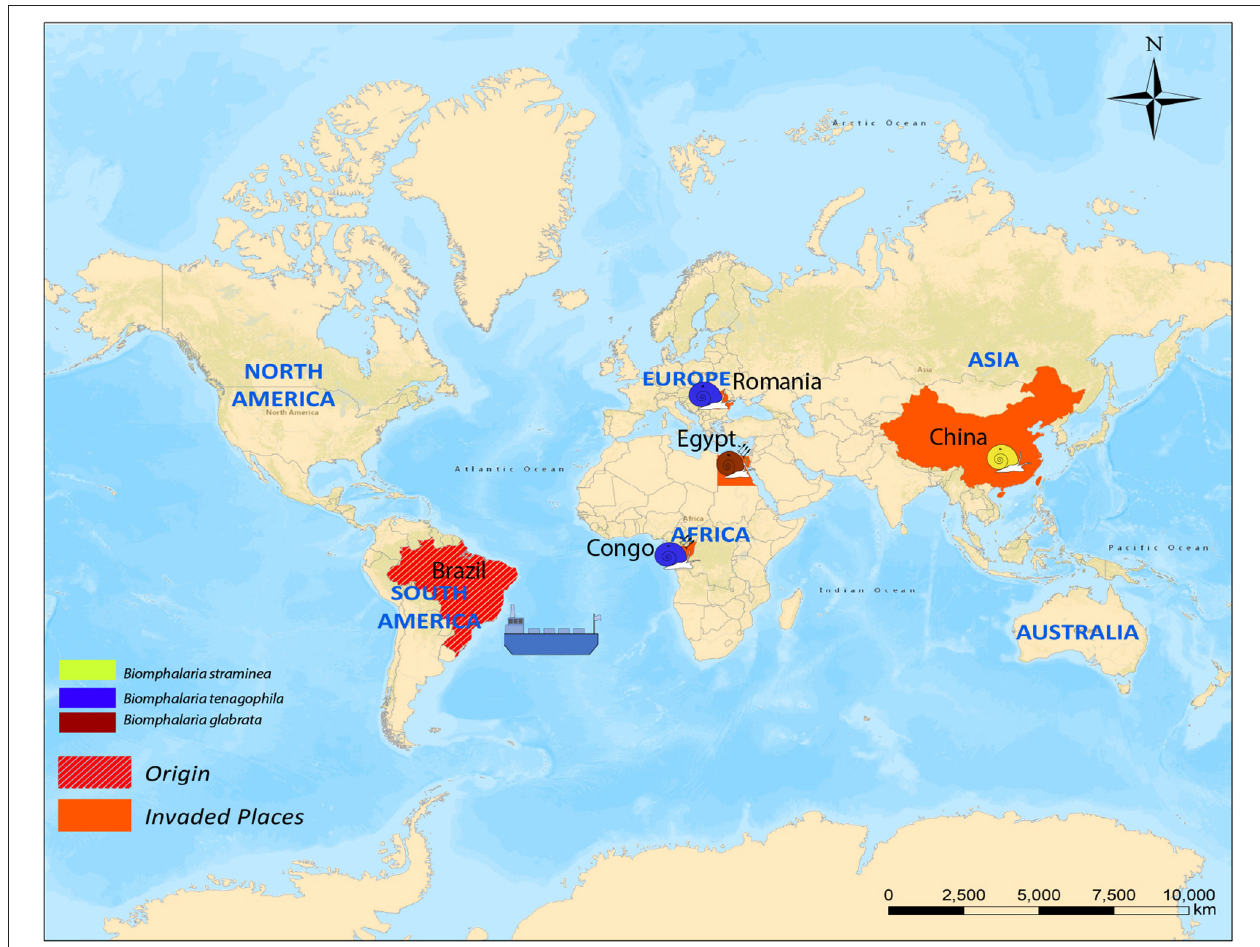
FIGURE 2 | Cases of long-distance dispersal of different Biomphalaria